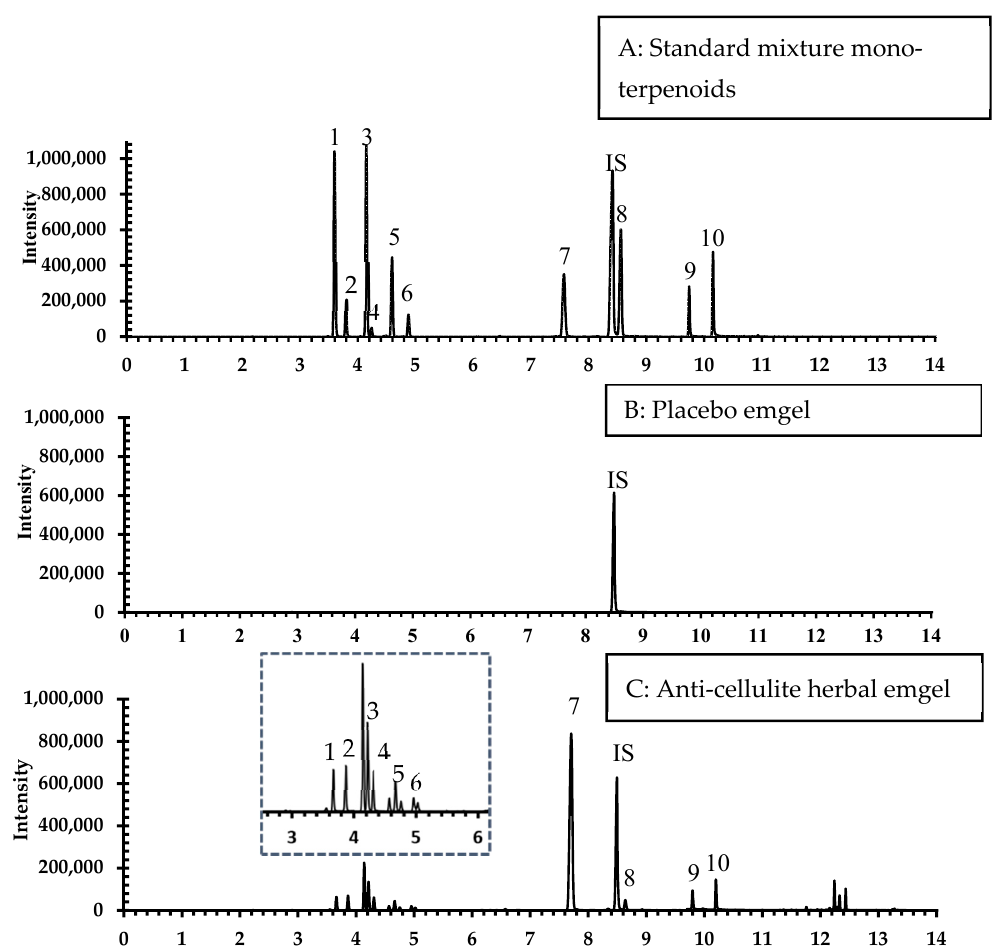
Figure 1. HS-GCMS (SIM) total ion chromatograms of ( A ) standard monoterpenoid mixture (2.5 µ g/mL), ( B ) placebo emgel (20 mg), and ( C ) anti-cellulite herbal emgel. The peaks of 10 constituents were identified by comparison with standard references as (1) α -pinene (RT 3.61), (2) camphene (RT 3.81), (3) β -pinene (RT 4.16), (4) myrcene (RT 4.25), (5) 3-carene (RT 4.61), (6) D-limonene (RT 4.89), (7) camphor (RT 7.59), (8) terpinene-4-ol (RT 8.55), (9) β -citral (RT 9.75), and (10) α -citral (RT 10.16).